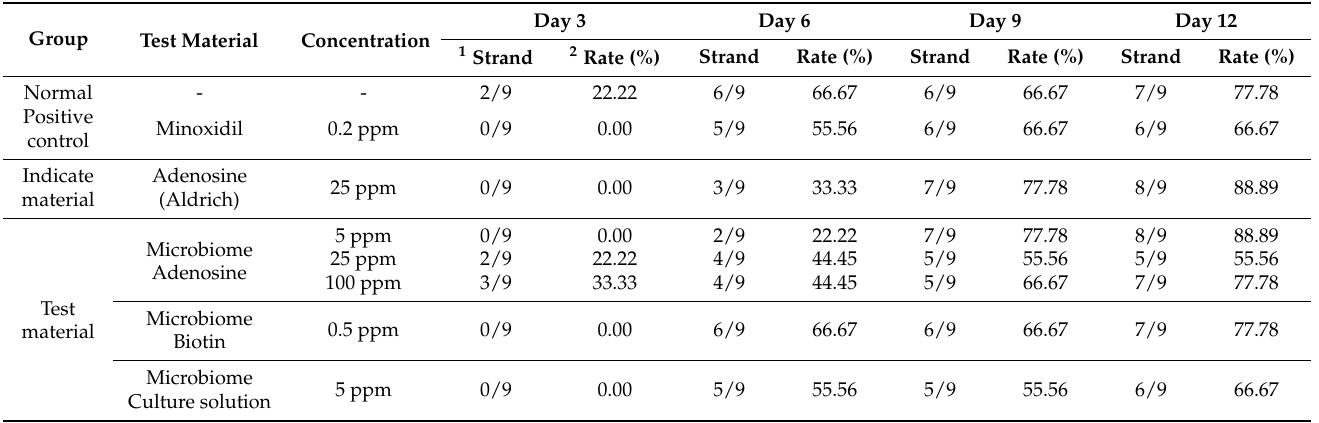
1 Strand: A number of hairs in catagen stage/a total number of hairs. 2 Rate (%): A number of hairs in catagen stage/a total number of hairs × 100.